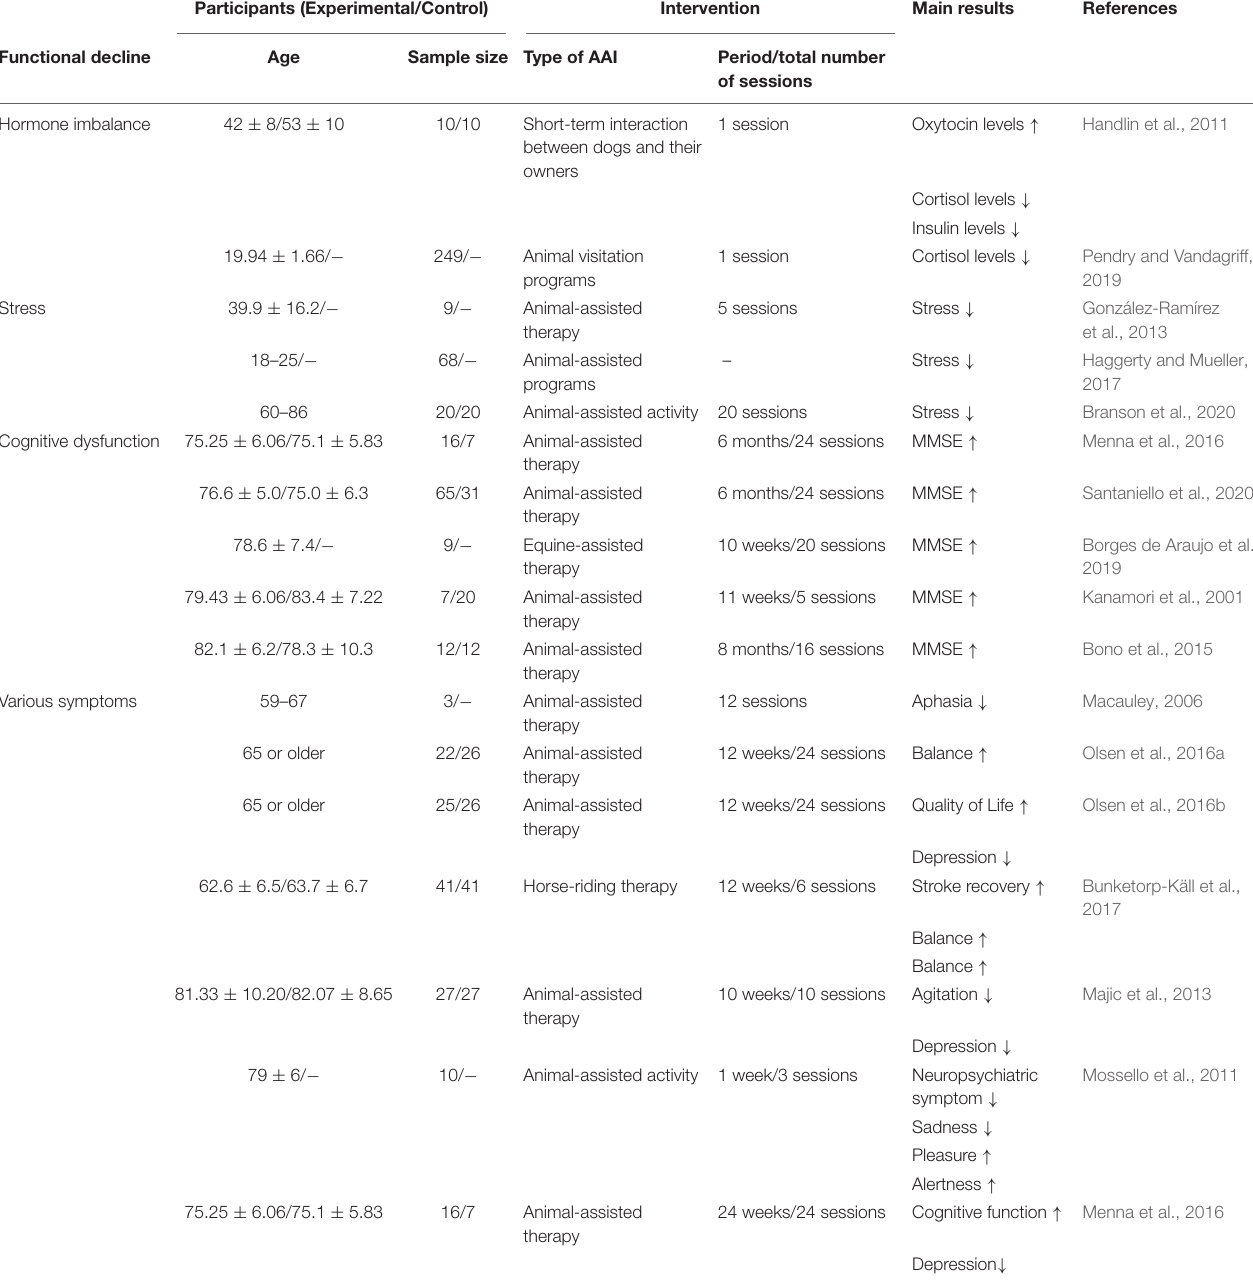
TABLE 1 | The effects of AAI on healthy individuals and patients with neurodegenerative disease. Participants